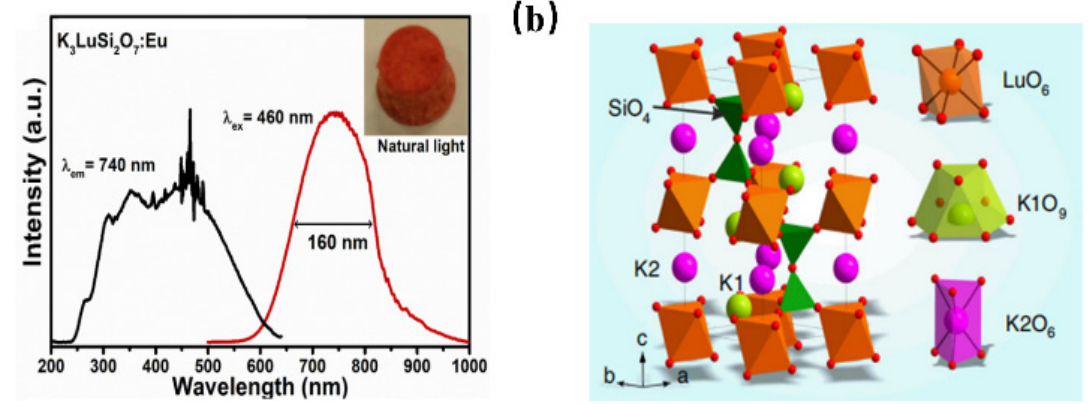
Figure 8. ( a ) PL and PLE spectra of K 3 LuSi 2 O 7 : Eu 2+ (Ex = 460 nm, Em = 740 nm) and ( b ) crystal structure of K 3 LuSi 2 O 7 .